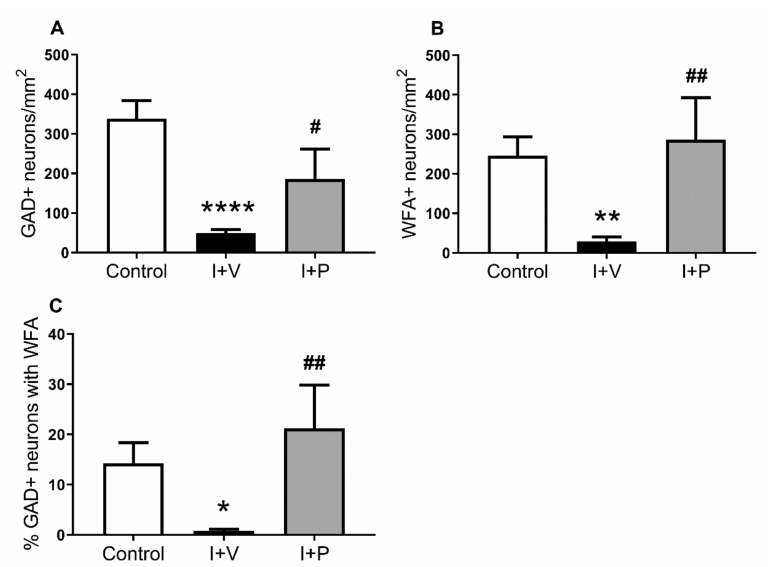
Figure 4. Interneuron survival and changes in perineuronal nets (PNNs) in layer 6 of the parasagittal cortex in sham control (control), cerebral ischemia (ischemia + vehicle (I + V)), and cerebral ischemia + memetic peptide treatment (ischemia + peptide (I + P)) groups at 7 days recovery. Densities (cells / mm 2 ) of interneurons and PNNs identified with glutamate decarboxylase (GAD) + ( A ), Wisteria floribunda agglutinin (WFA) ( B ), and the percentage of GAD + interneurons with PNNs ( C ). Data are mean ± standard error of the mean. Control group ( n = 6 animals). I + V group ( n = 9). I + P group ( n = 5). * p < 0.05, ** p < 0.01, and **** p < 0.0001 ischemia vs. control; # p < 0.05 and ## p < 0.01 treatment vs. ischemia. Note that analysis of cell densities was performed on double-labelled brain sections visualized with immunofluorescence detection. GAD + cells and PNNs (c.f. controls in Figure 3) were counted in layer 6 of the first and second gyri of the parasagittal cortex (see Figure 5) using reflected fluorescence microscopy (40 × objective) and the fractionator probe (see Section 4. Materials and Methods, Image Analysis subsection).